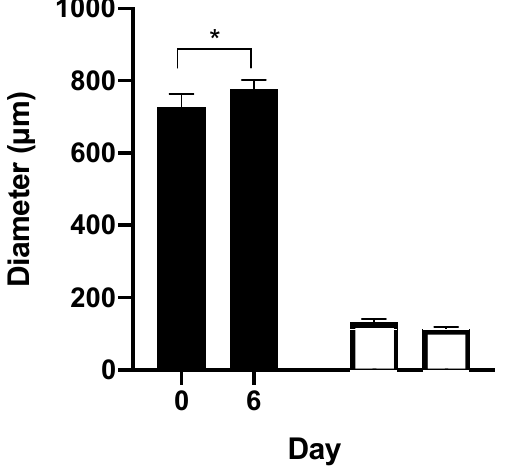
Figure 7. In vitro culture of oocytes in microcapsule for 6 days.